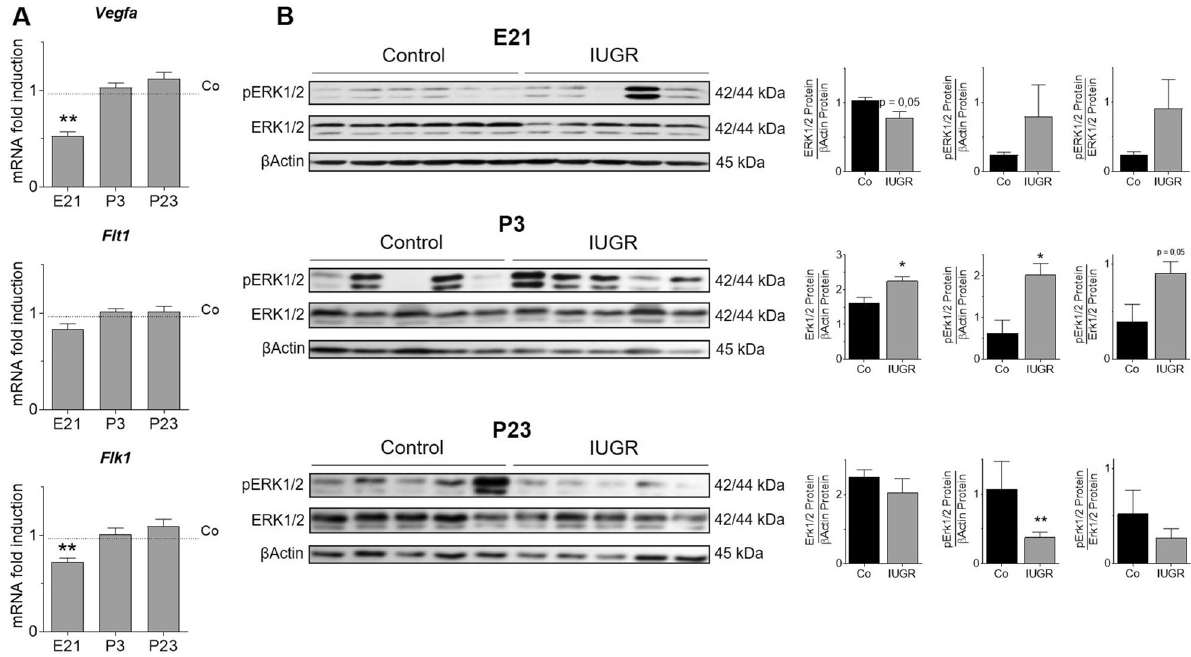
Figure 3. IUGR dysregulates gene expression of components and the activation of vascular endothelial growth factor (VEGF) signaling in lungs. ( A ) Assessement of Vegfa , VEGF-Receptor 1 ( Flt1 ) and VEGF-R2 ( Flk1 ) on embryonic day (E21), postnatal day 3 (P3), and P23 using qRT-PCR; Glyceraldehyde 3-phosphate dehydrogenase ( Gapdh ) served as housekeeping gene; the Control group was set at 1 (n = 10/group). ( B ) Immunoblots illustrating protein abundance of total ERK1/2 and phosphorylated ERK1/2 (pERK1/2) on E21, P3 and P21; pERK1/2 was related to βActin or to total ERK1/2; the densitometric analysis is shown next to the respective immunoblot (n = 5–6/group). Mean ± SEM. A non-parametric T-test was used to compare IUGR to the control group,*p < 0.05, **p <